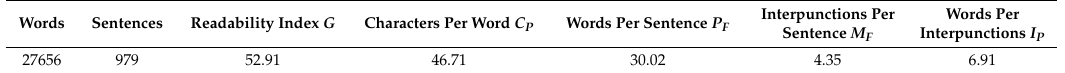
Table 5. Statistics of readability index G , number of text characters per word ( C P ), number of words per sentence ( P F ), number of punctuation marks per sentence ( M F ) and number of words per punctuation marks, namely the word interval ( I P ), all values calculated as discussed in general terms in [4], for the Comments to Revelation